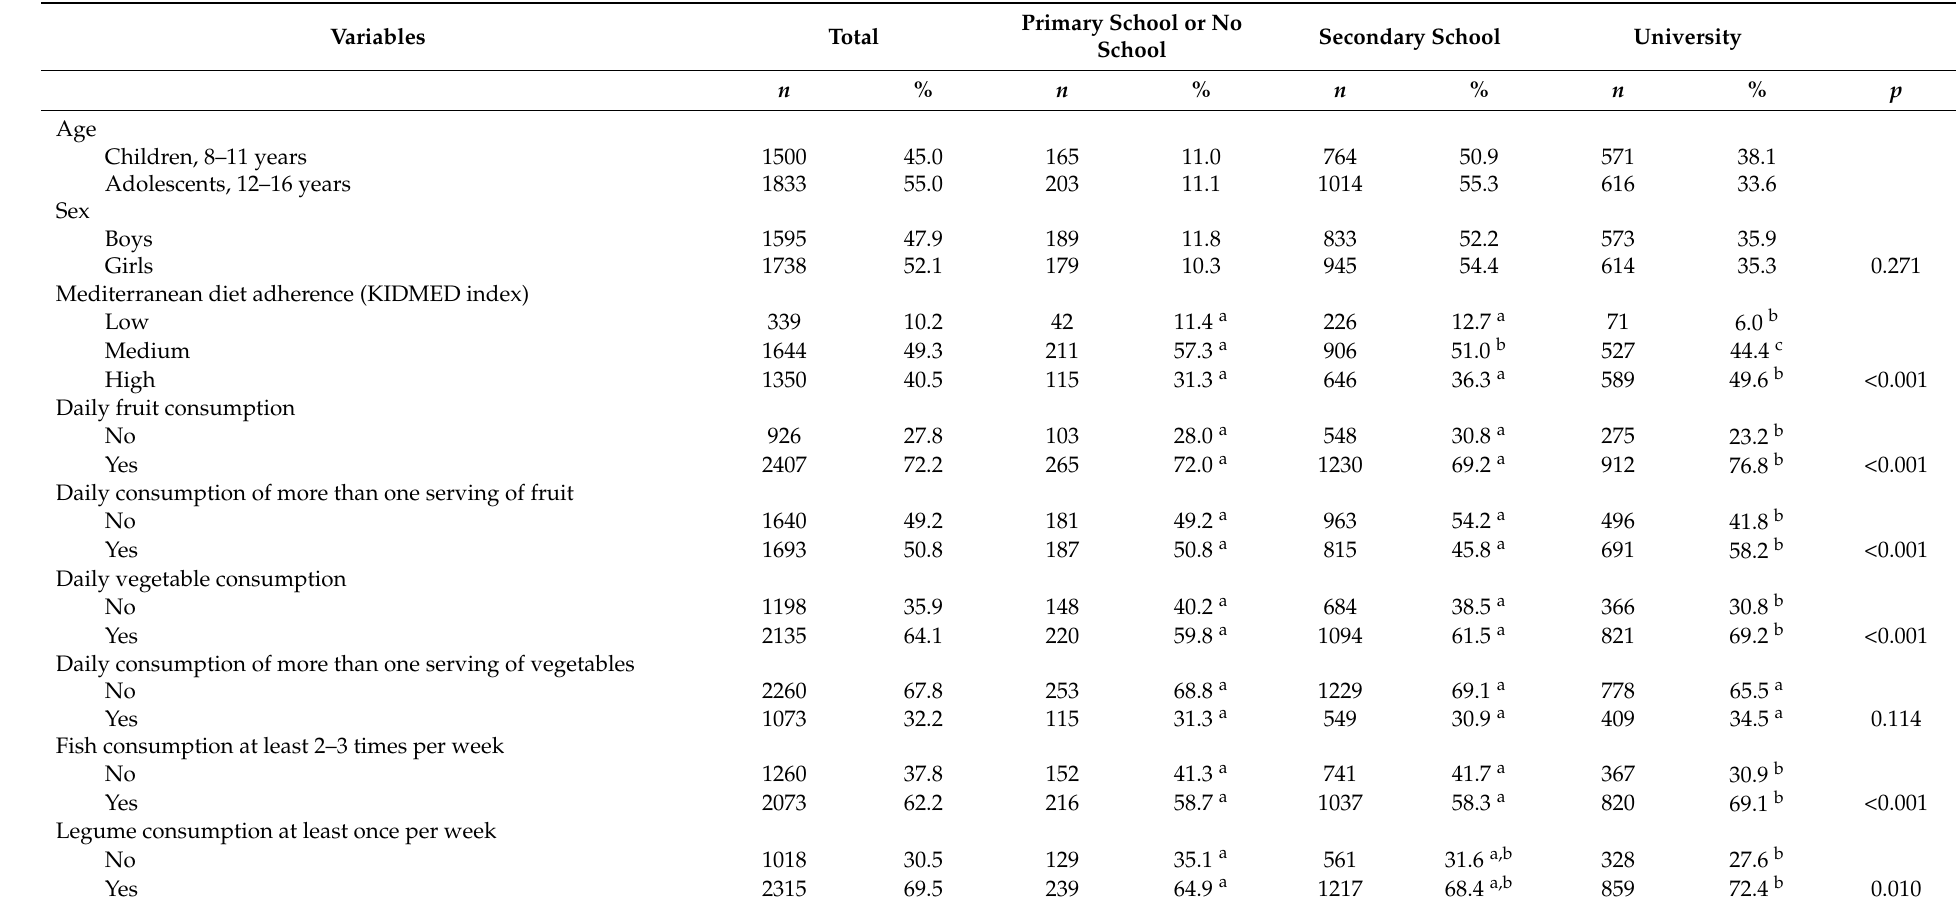
Table 1. Characteristics of study participants: age, sex, and adherence to the Mediterranean diet for the total study population and according to parents’ education level. KIDMED: Kids’ level of adherence to the Mediterranean